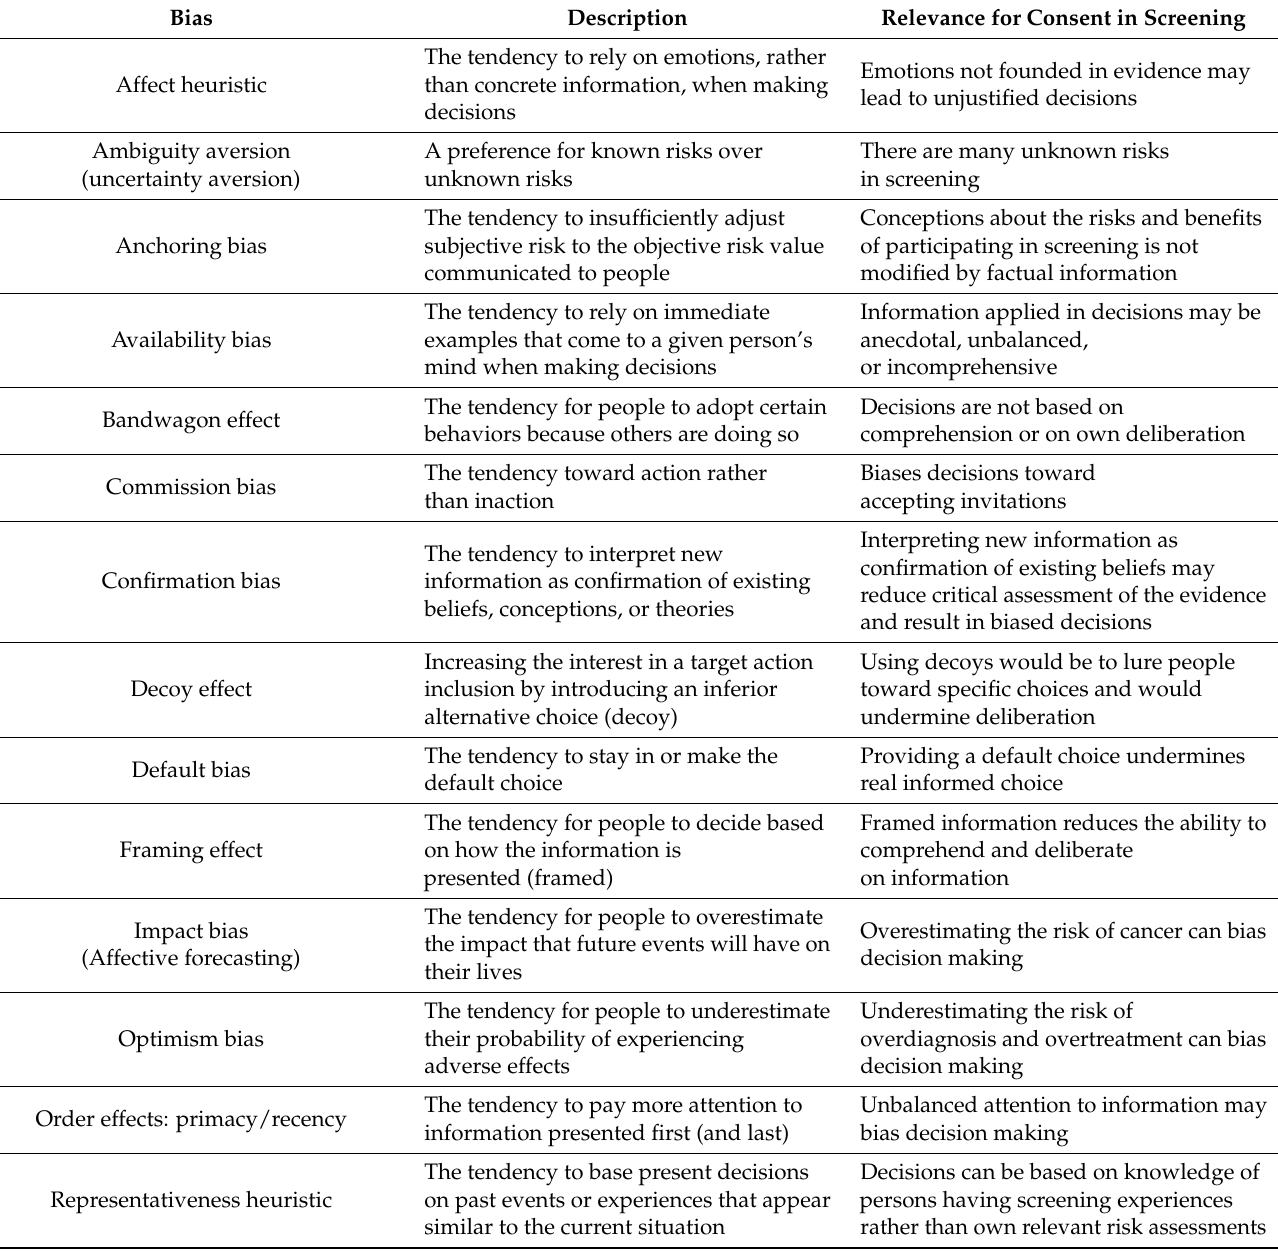
Table 2. A summary of relevant biases (and heuristics) for decision making on participating in screening programs. Useful reviews of the general literature can be found in